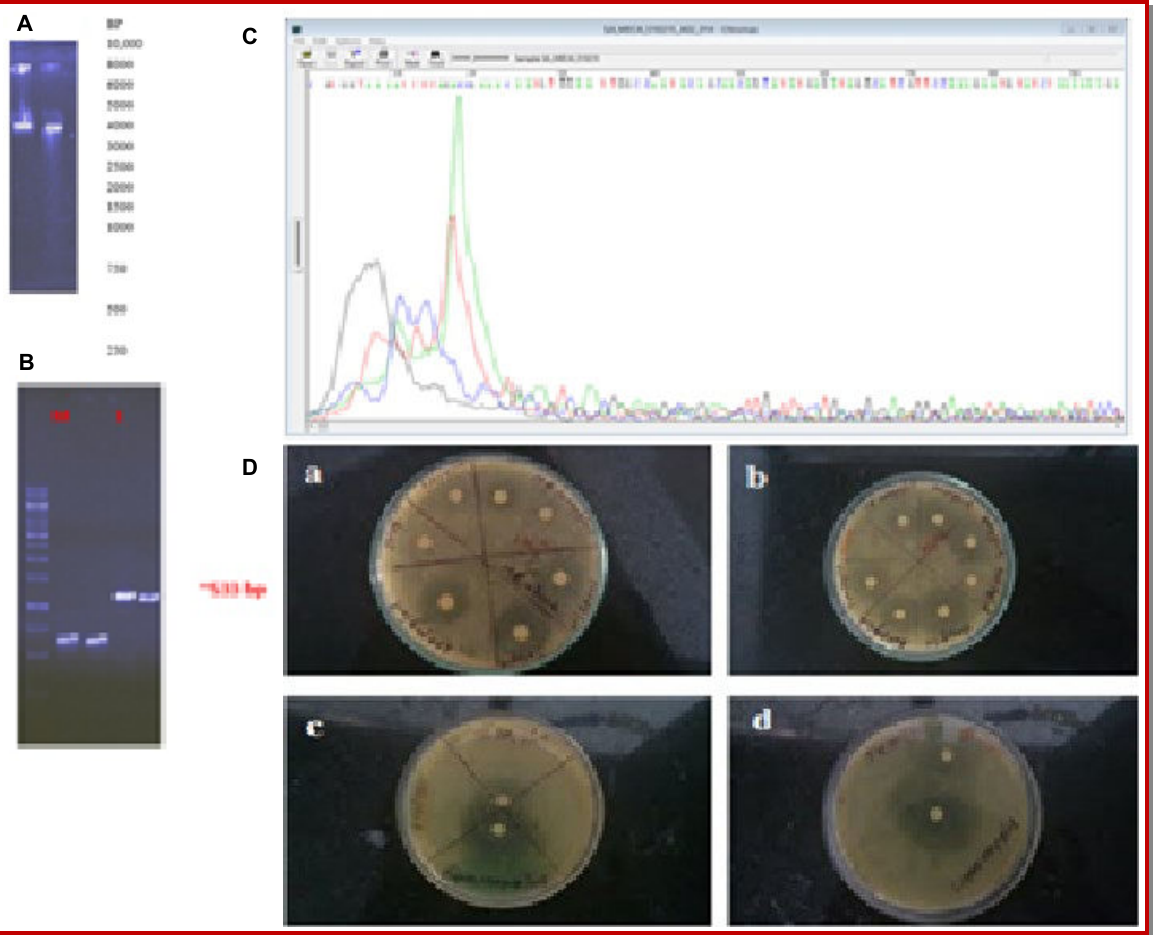
Figure 1: Bacterial genomic DNA (A); PCR amplification of mec A gene from Staphylococcus aureus (B), Lane M: 1 kBP DNA ladder; Lane 1: mec A gene from S. aureus ; Sequence of mecA gene (C); Zone of inhibition of bacterial growth for various drugs and combi- nations of antibiotics and drugs (D), a. Antispasmodic drug mebevereine against E. faecalis, b. Antiulcer drug troxipide alone against E. faecalis, c. Antibiotics with antispasmodic drug against E. faecalis, d. Antibiotics with antiulcer drug against E.